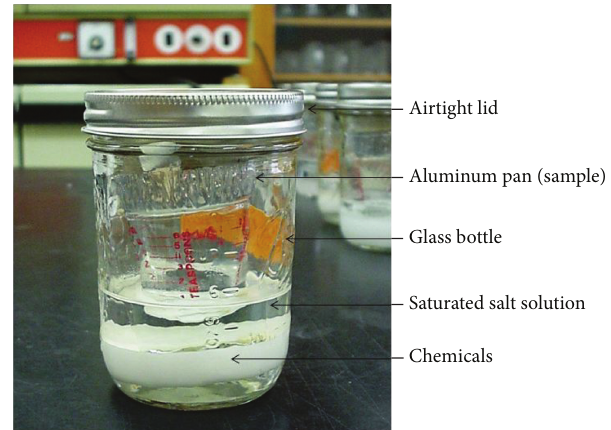
Figure 1: Experimental setup for establishing different water activ- ities in containers using different saturated salt solutions. One gram of soy/PE fiber sample was placed in each jar in aluminum